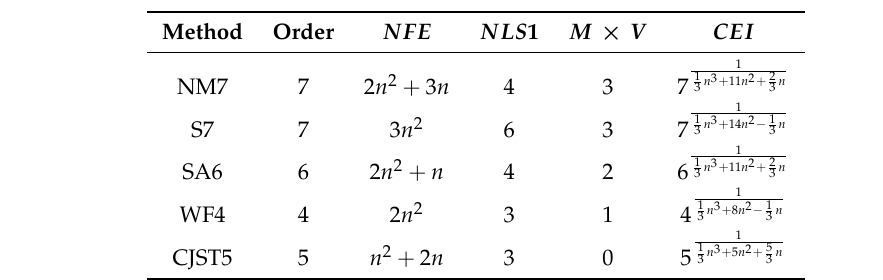
Figure 1. CEI for several sizes of the system. Table 2. Computational cost of the